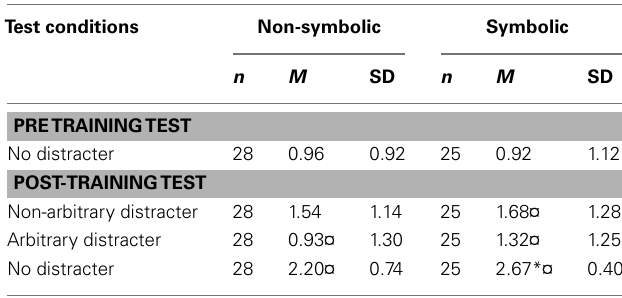
Table 1 | Mean values ( M ) and standard deviations (SD) for scorings concerning test trials with different test